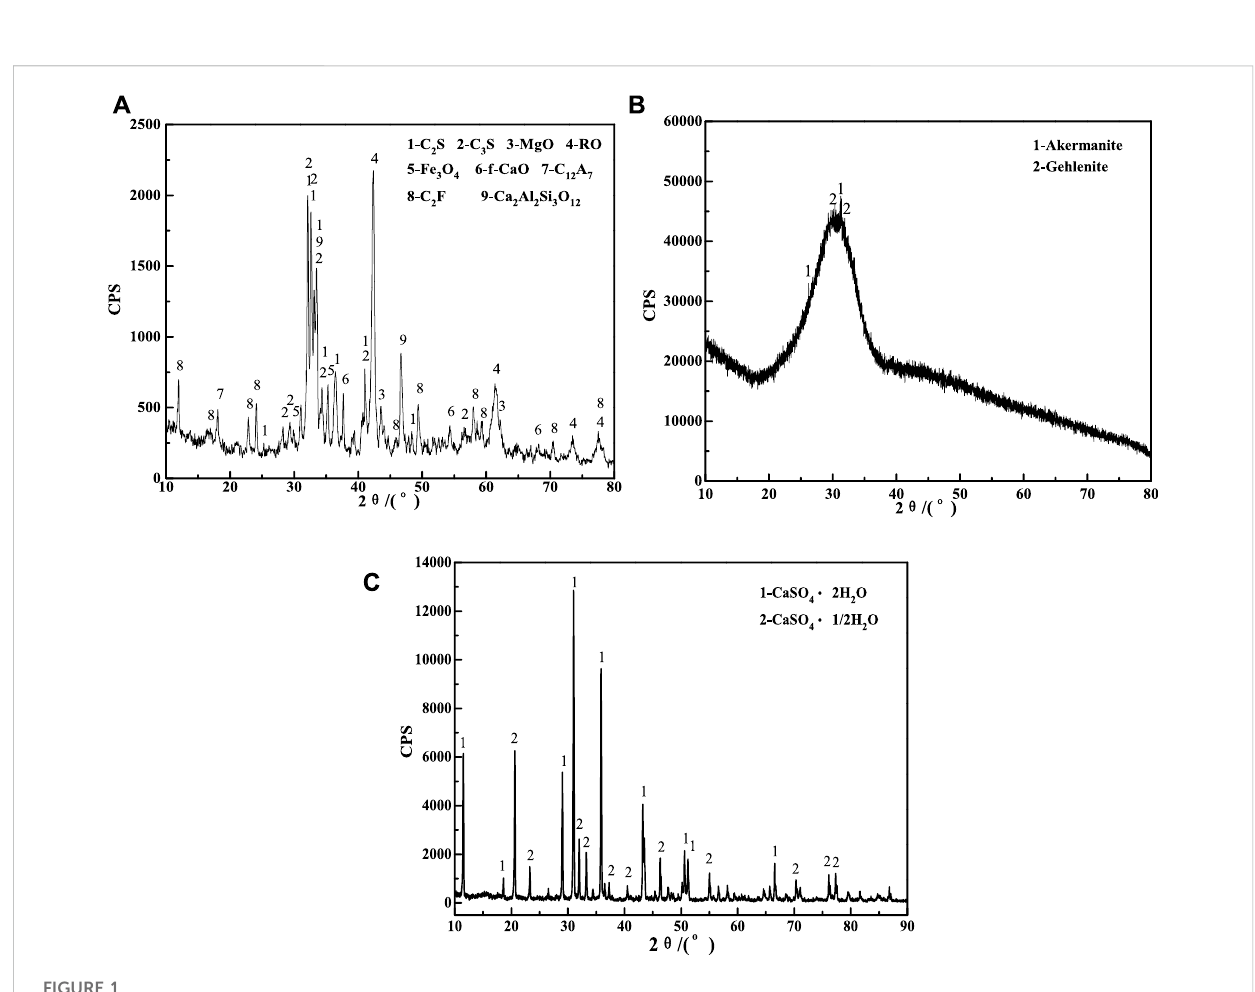
FIGURE 1 XRD patterns of raw materials. (A) SS; (B) GBFS; (C)